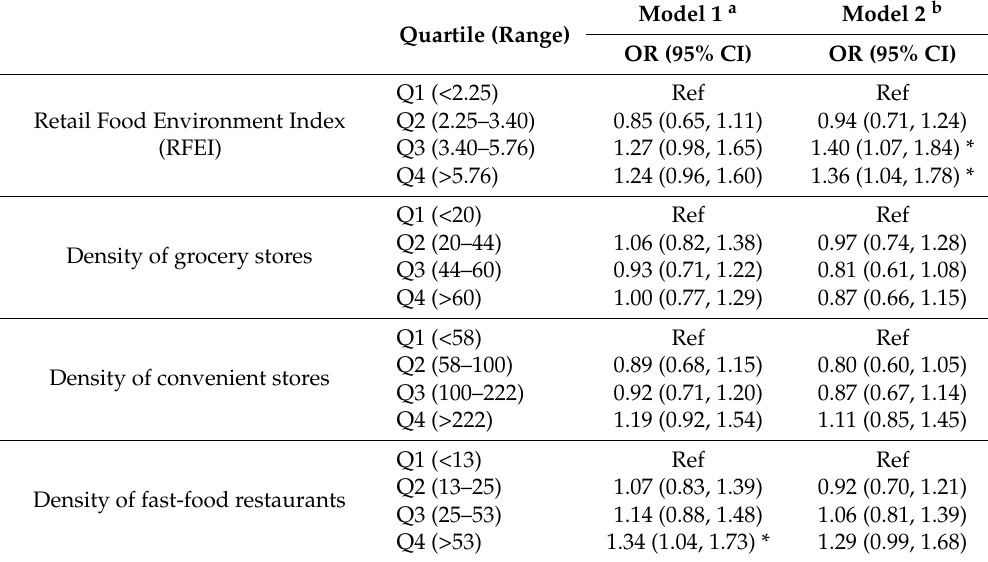
Table 3. Associations between local food environment and odds of infrequent fruit consumption (<7 days/week) among adults in Hong Kong with binary logistic regression